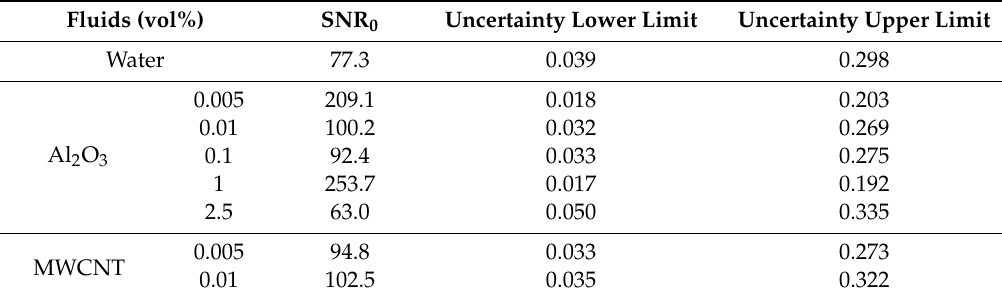
Table 1. SNR 0 and the corresponding lower and upper limits of standard uncertainty.